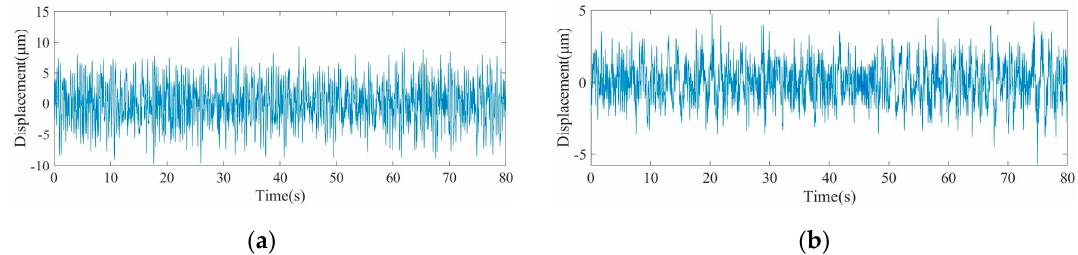
Figure 8. The comparison of horizontal and vertical displacements of a typical guide wall block. ( a ) Horizontal displacement; ( b ) vertical displacement.